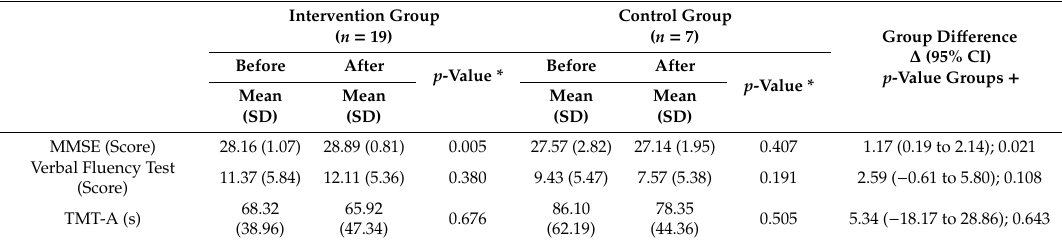
Table 4. Results of cognitive functioning outcomes by group.